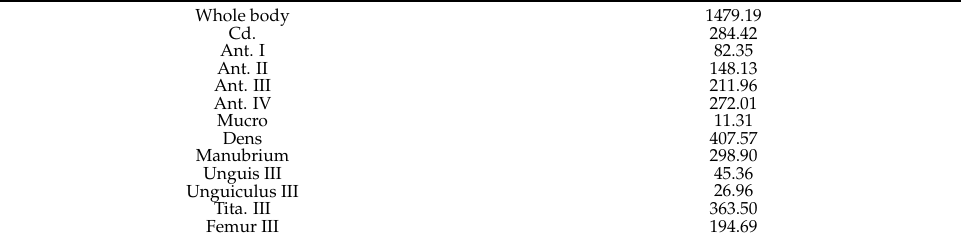
Table 2. Seira musarum —measurements ( µ m) of neotype body